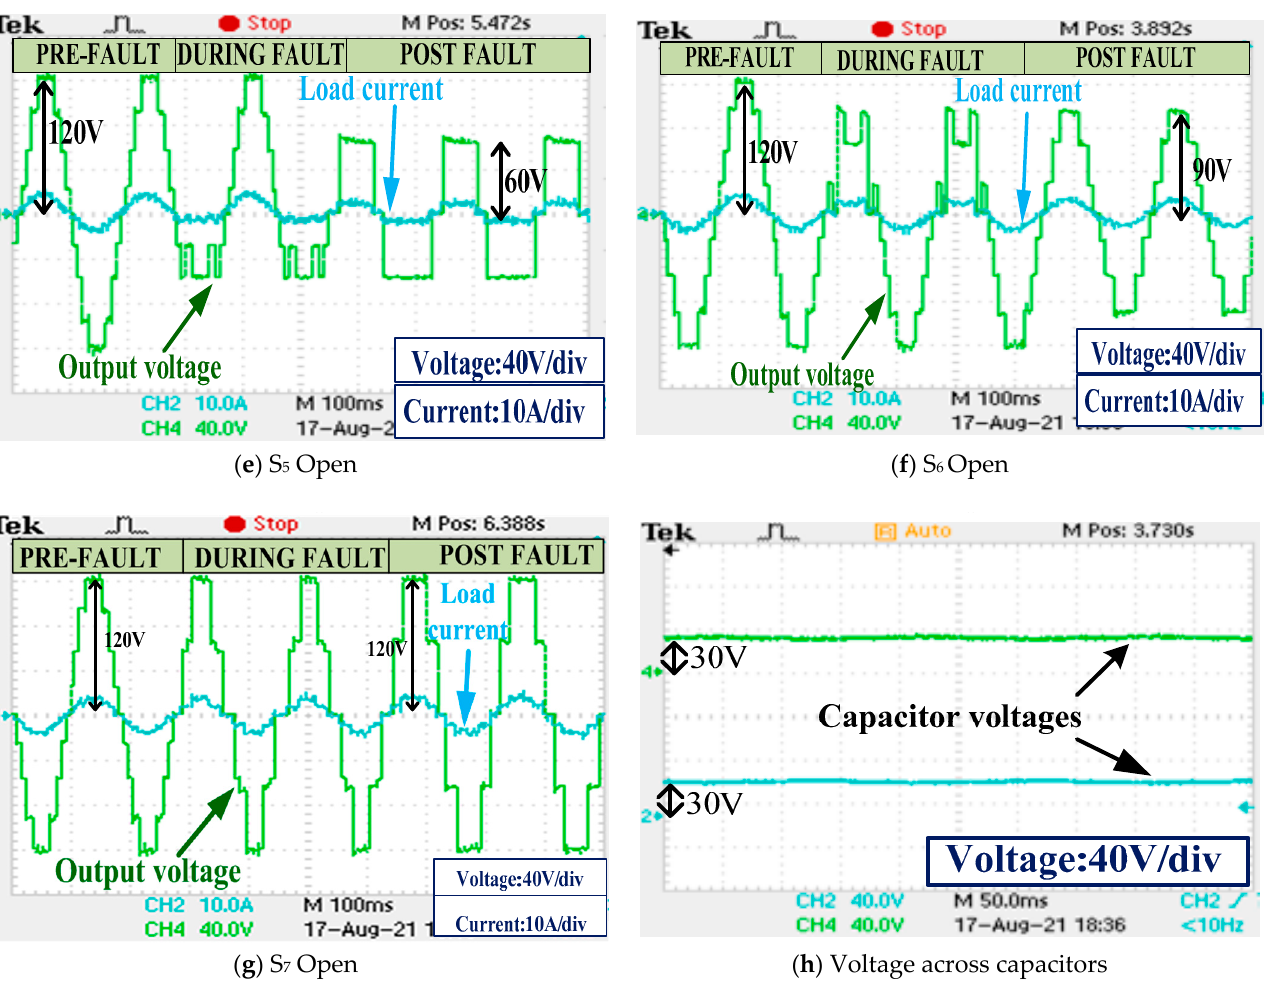
Figure 10. Experimental results: voltage across the output and current through the load waveform showing pre-fault, during-fault and post-fault conditions for switches; ( a ) S 1 or S 8 ( b ) S 2 , ( c ) S 3 , ( d ) S 4 or S 8 , ( e ) S 5 and ( f ) S 6 ; ( g ) S 7 Open, ( h ) voltage across capacitors for fault across each